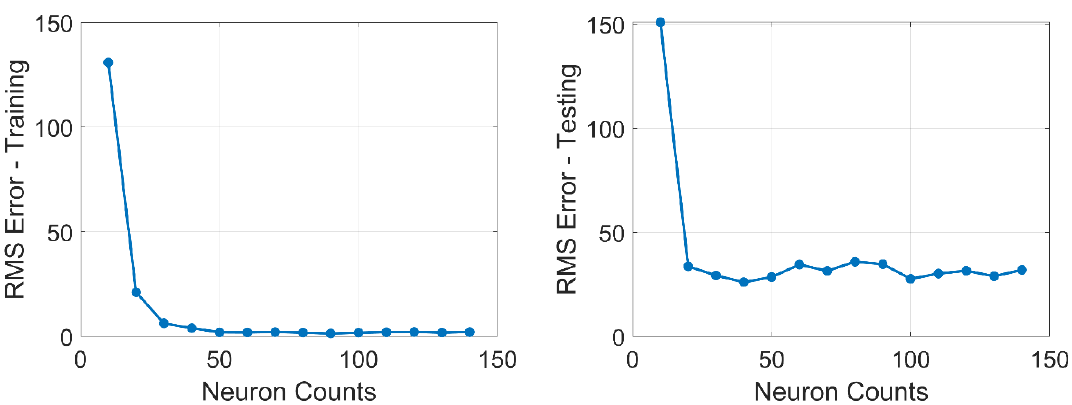
Figure 6. Optimum neurons in the hidden